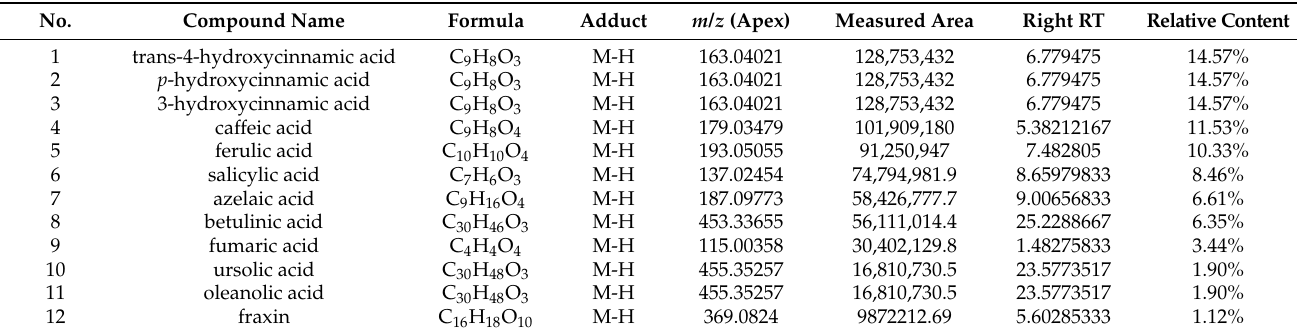
Table 3. Information table of chemical compositions of